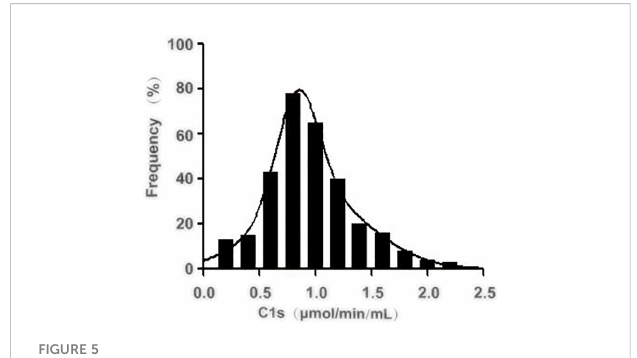
FIGURE 5 Distribution of the activated complement C1s activity in serum from healthy individuals. The activity of C1s was analysed by FRET-based immunoassay. n =